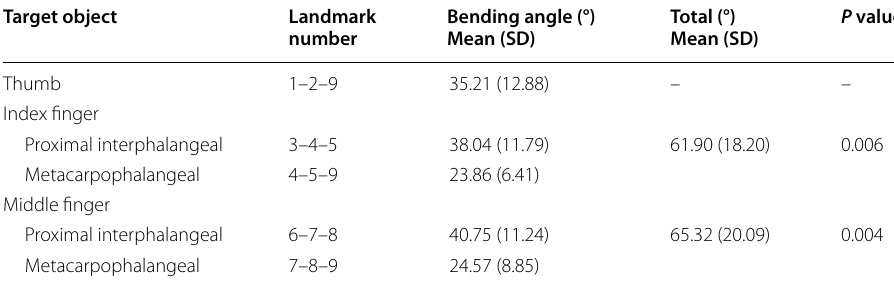
Table 4 Measurement results for participants’ finger‑bending angles